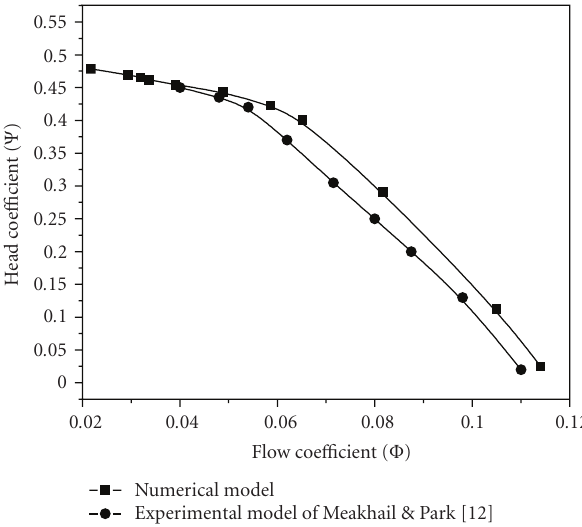
Figure 3: Validation characteristics curve of head coe ffi cient with flow coe ffi